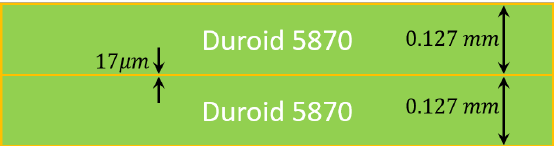
Figure 16. Blass matrix cross section.